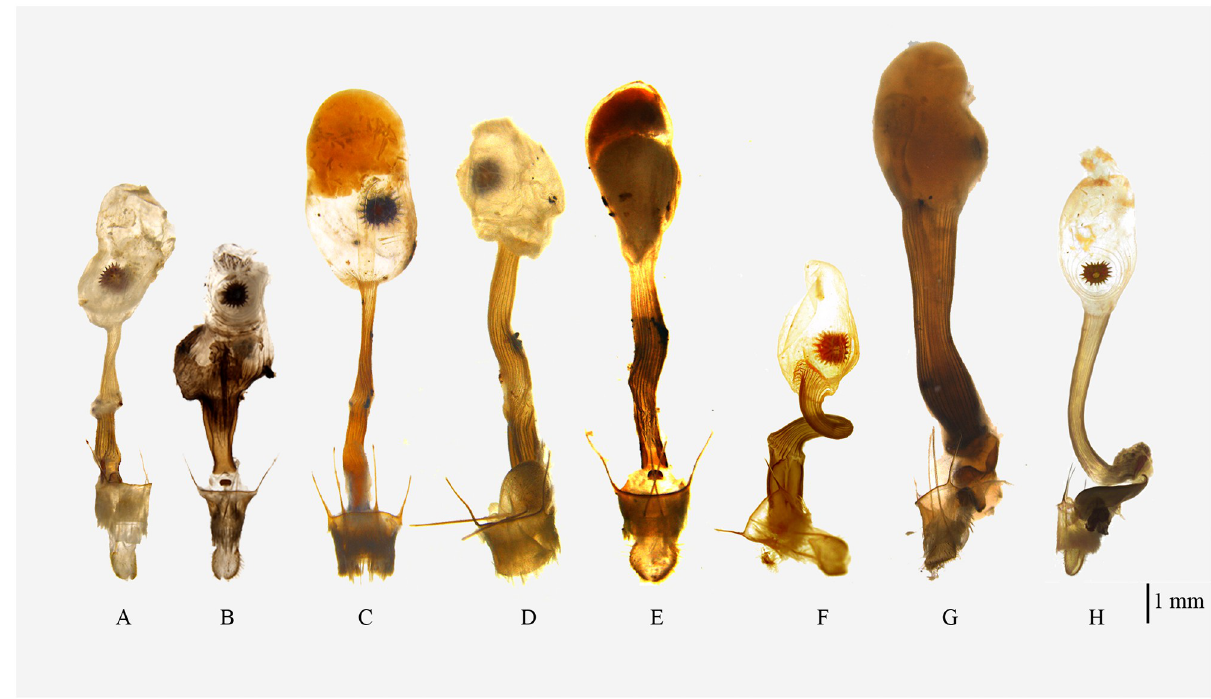
Fig 6. Female genitalia of Psyra species. A. P . gracilis B. P . angulifera C. P . cuneata D. P . dsagara E. P . similaria F. P . falcipennis G. P . crypta H. P . spurcataria .